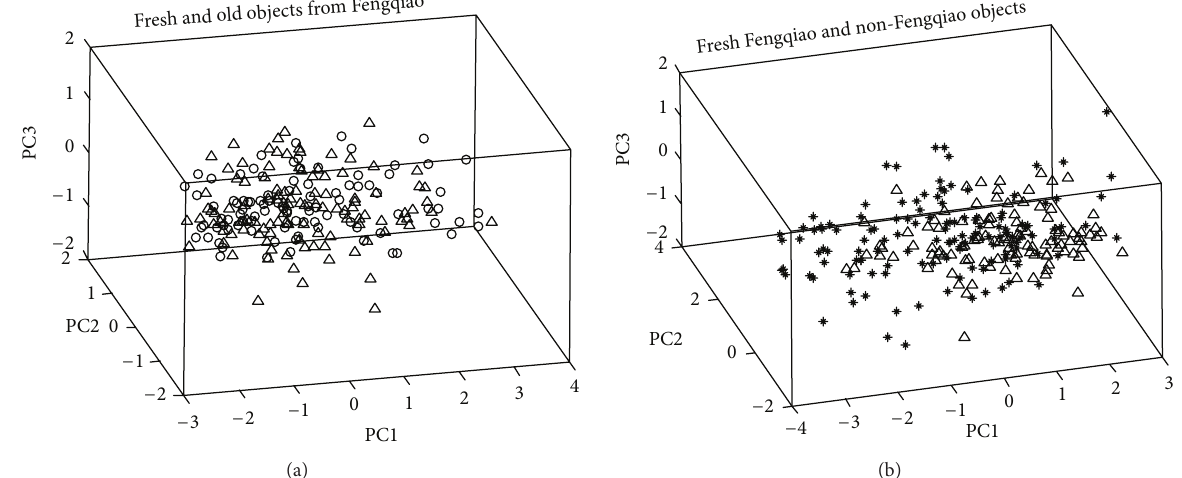
Figure 2: PCA plot of raw NIR spectra (4000–9000 cm −1 ) of different seed kernels; Fengqiao (old, 𝑛 = 97 , I ), Fengqiao (fresh, 𝑛 = 110 , △ ), and other areas (fresh, 𝑛 = 130 , ∗